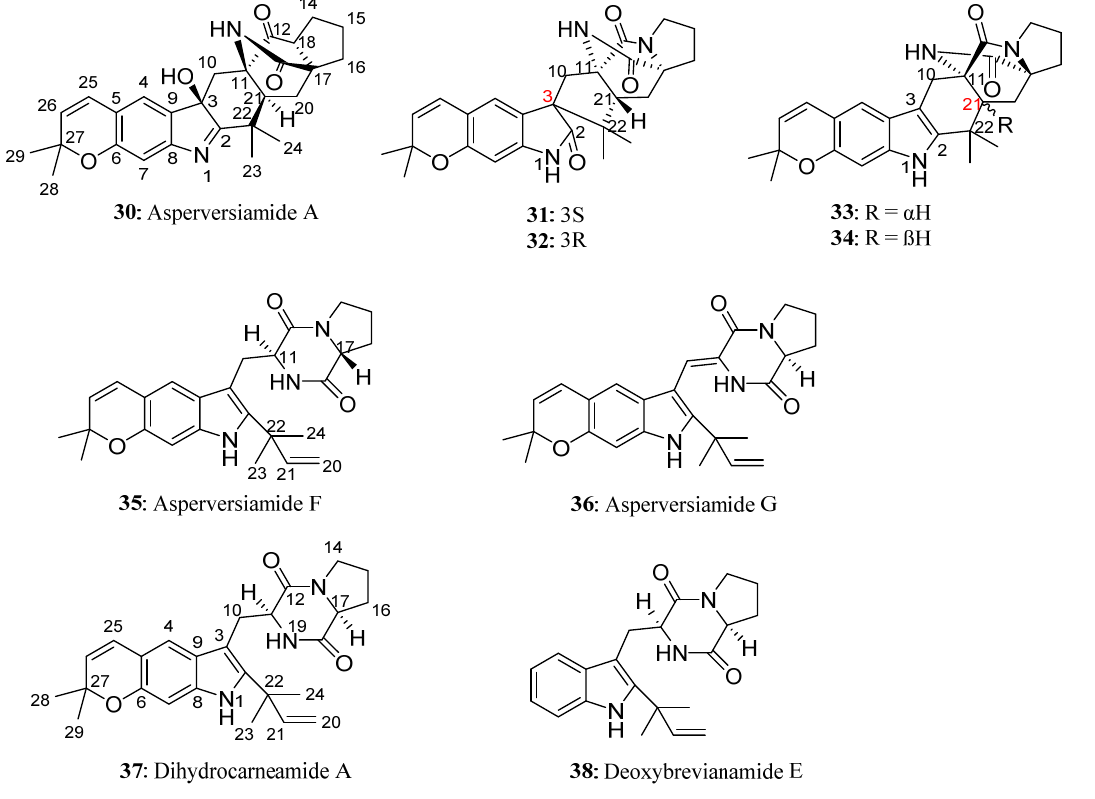
Figure 7. The structure of compounds 30 - 38 .